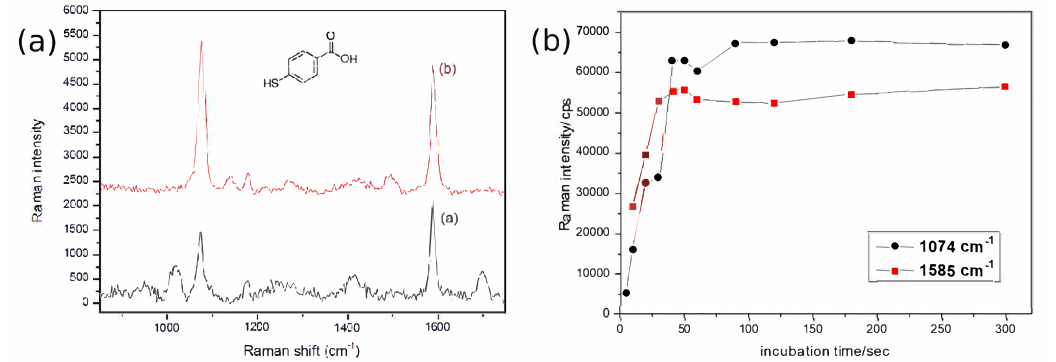
Figure 5. ( a ) Spontaneous Raman spectrum of 4-mercaptobenzoic acid (4-MBA) of (0.5 M) in DMSO solution (spectrum a), and surface enhanced Raman scattering (SERS) spectra of 4-MBA molecules adsorbed on a gold nanodisc array (concentration of 10 − 4 M, sepctrum b). Acquisition conditions for SERS: excitation wavelength λ exc = 632.8 nm, laser power P = 65 µ W, acquisition time t = 30 s; ( b ) SERS intensity as a function of incubation time for the Raman bands at 1074 cm − 1 and 1585 cm − 1 . Acquisition